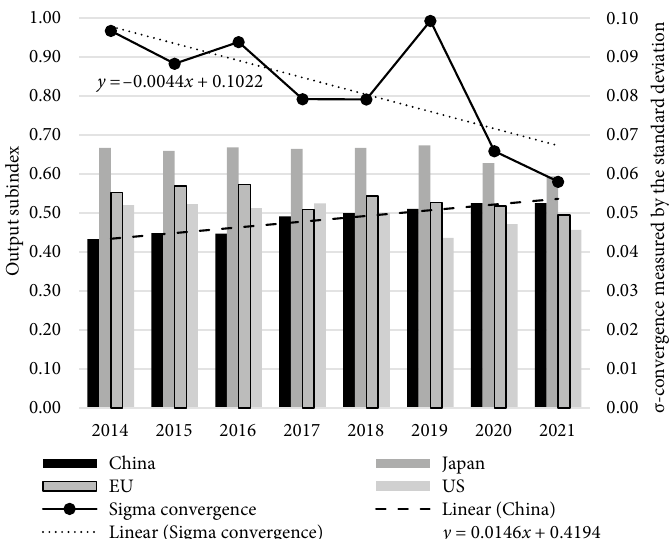
Figure 5. The values of output subindexes for China and the Triad: the EU, Japan, and the US (source: author’s computations using data from the European Innovation Scoreboard